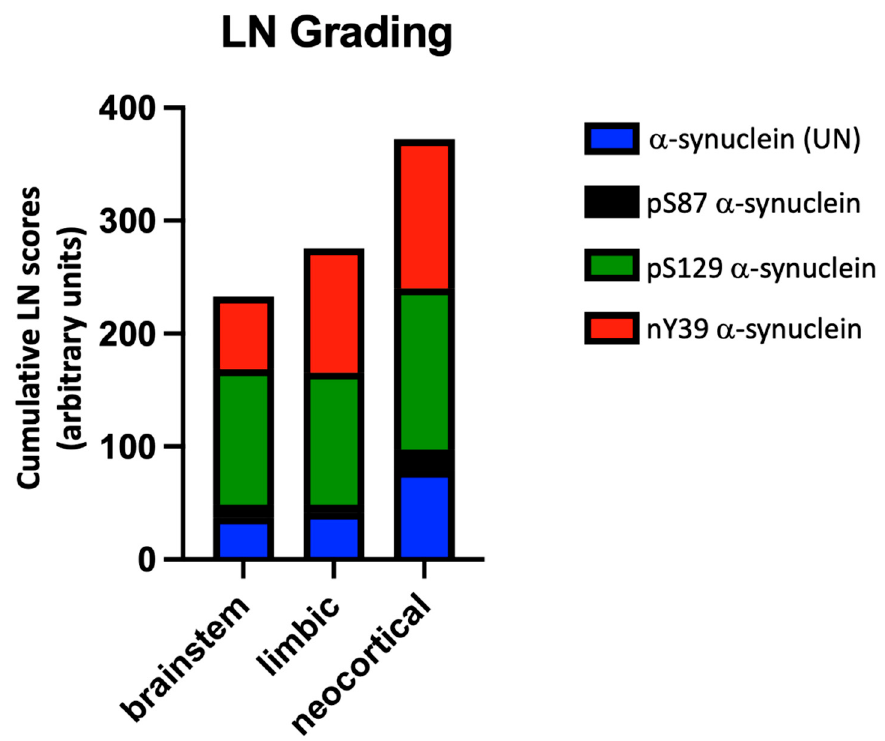
Figure 3. Column bars representing cumulative LN scores of the 4 α -synuclein antibodies used in brainstem, limbic, and neocortical cases.